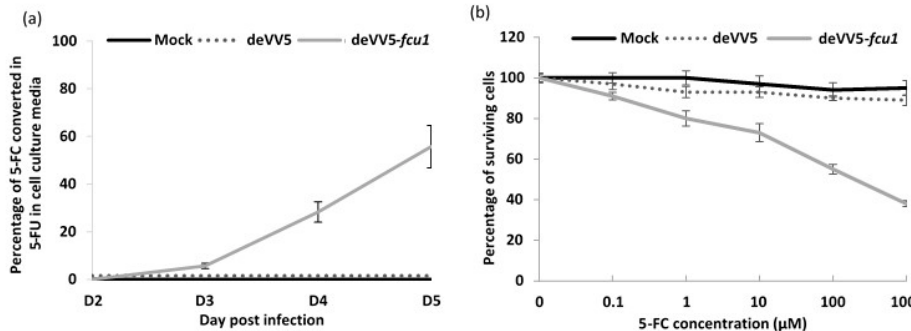
Figure 4. Functionality and efficacy of FCU1 expressed by deVV5. ( a ) Conversion of 5-fluorocytosine (5-FC) to 5-fluorouracil (5-FU) and release of 5-FU in the cell culture supernatant. HCT 116 cells were infected with the indicated vector at a MOI of 10 –5 and then incubated with 0.1 mM 5-FC from day 2 to day 5 post infection. The relative concentration of 5-FC and 5-FU in the culture supernatant was measured by HPLC. The results are expressed as the percentage of 5-FU released relative to the total amount of 5-FC + 5-FU. Each data point represents the mean of triplicate determinations ± SD. ( b ) In vitro sensitivities of infected human tumor cells to 5-FC. HCT 116 human tumor cells were mock-infected or infected with deVV5 and deVV5- fcu1 at a MOI of 10 –5 . After 48 h, cells were treated by increasing concentrations of 5-FC. Cell survival was determined 3 days later as described in Materials and Methods section. Cell viability results are expressed as the percentage of viable cells in the presence and absence of the prodrug. Values are represented as mean ± SD of triplicate determinations.